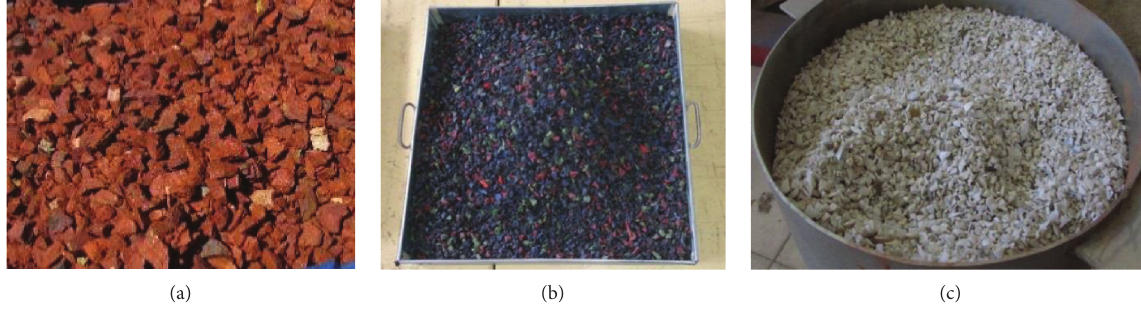
Figure 2: Physical representation of various coarse aggregates. (a) Brick chips. (b) PP aggregate. (c) PET aggregate.